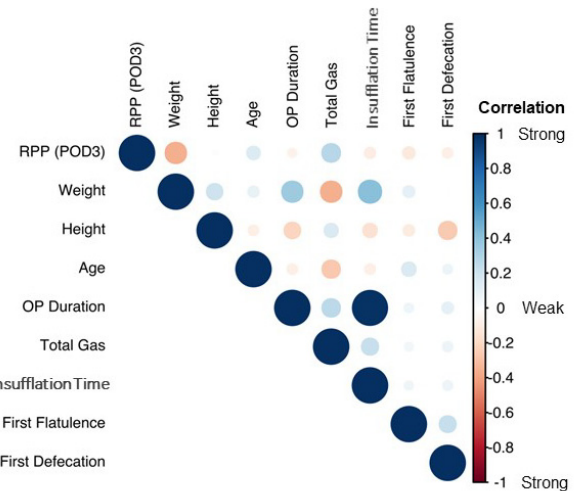
Figure 3. Correlation plot with demographic and operative data. Light color/circular shape: weak correlation; strong color/elliptical shape: strong correlation.